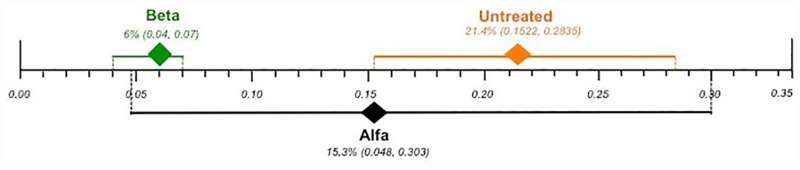
Comparison of the plotted proportional meta-analysis, according to ERT regimens, for renal complications.Effect differences were seen due to the non-overlap of the 95% confidence intervals favoring the use of agalsidase beta compared to untreated patients, as their CIs did not overlap. There was no statistically significance difference between agalsidase alfa and both untreated patients and agalsidase beta, as their CIs overlapped.